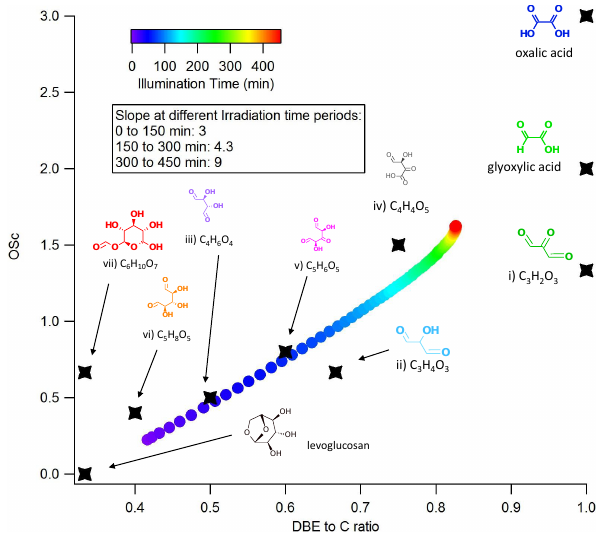
Figure 7. OSc vs DBE / #C plot. The intensity-weighted average OS c and DBE / #C from the products listed in Supplement Table S1 are displayed here. The color code represents the illumination time. The coordinates of major compounds are also shown.